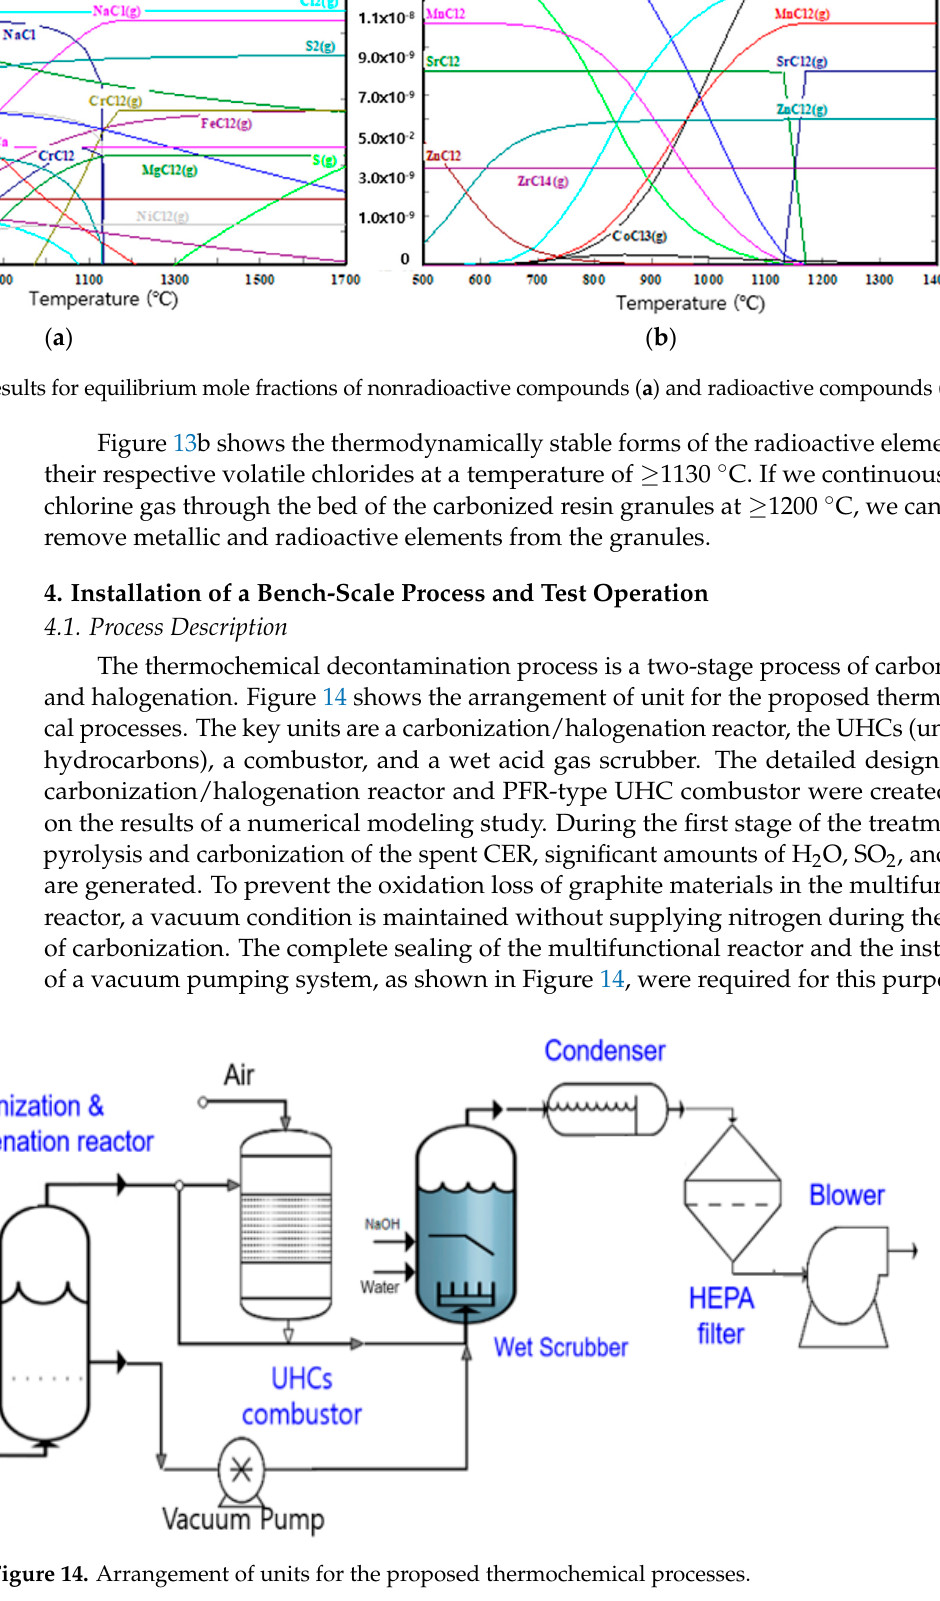
Figure 14. Arrangement of units for the proposed thermochemical processes.